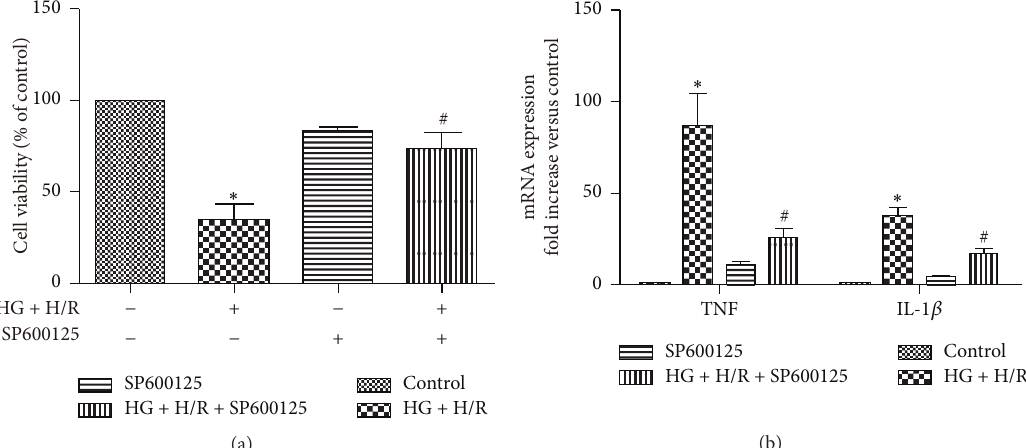
Figure 6: Protection of JNK inhibitor SP600125 against HG + H/R induced loss of cell viability and proinflammatory cytokines release. (a) Protective effects of SP600125 on HG + H/R induced loss of cell viability. (b) Effect of SP600125 on HG + H/R induced proinflammatory cytokine expression. Data are shown as mean ± SD of 3 independent experiments. ∗ 𝑃 < 0.05 versus control; # 𝑃 < 0.05 versus HG + H/R. with a putative JNK activator, ANISO (Figure 5(b)),